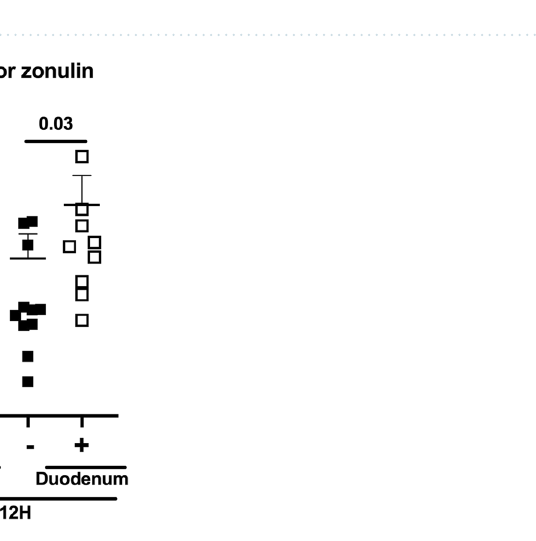
Figure 4. Gastric and duodenal percent of FITC-dextran. Percent FITC-dextran in the first three segments of the small intestine were summed and represent the duodenum. Individual values per mouse are represented. One-way ANOVA, p < 0.05. Long bars represent the statistical analysis between vehicle- and LPS-injected mice. Filled circles—WT vehicle-injected; Filled squares—Ztm vehicle-injected; Open circles—WT LPS-injected; Open squares—Ztm LPS-injected.